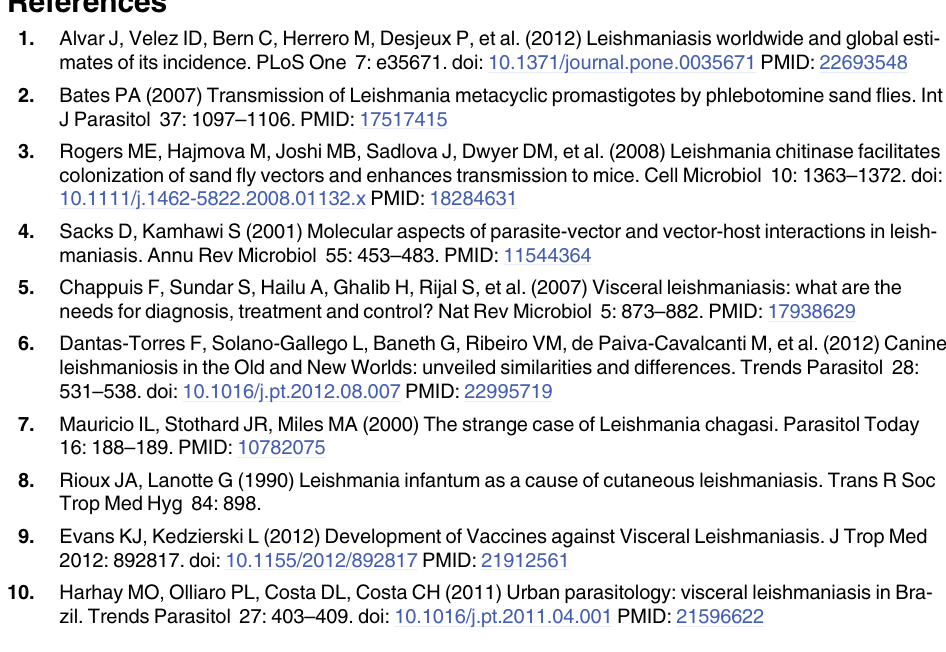
ity +/- standard deviation ( (cid:3) p < 0.05, (cid:3)(cid:3) p < 0.01, p < 0.001). S2 Fig. IL-4 and IL-10 productions by co-cultured cells from placebo and vaccinated (rPSA and Cter-rPSA) groups of dogs. (A) IL-4 and (B) IL-10 levels were determined by a two-site sandwich ELISA in cell culture supernatants of 72 h co-cultured cells. Values represent means +/- standard deviation of triplicate experiments. S3 Fig. Analysis of the production and purification of recombinant La PSA-12S protein by using Coomassie-stained SDS-PAGE gel. (lane 1) 5 μ g of the purified recombinant La PSA- 12S, (lane 2) 10 μ g of the purified recombinant La PSA-12S, (lane 3) SeeBlue Pre-stained Stan- dard. Staining by Coomassie blue reveals a band of about 16 kDa corresponding to the La PSA- 12S protein in monomeric form and a band of about 36 kDa corresponding to the dimerized